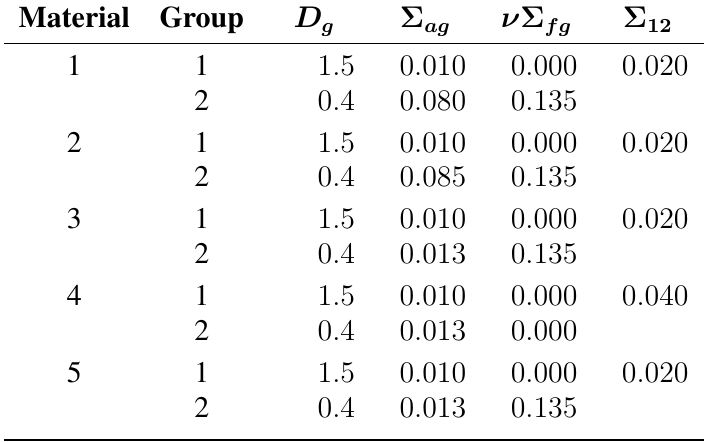
Table 1: Cross section data for 2D IAEA reactor.